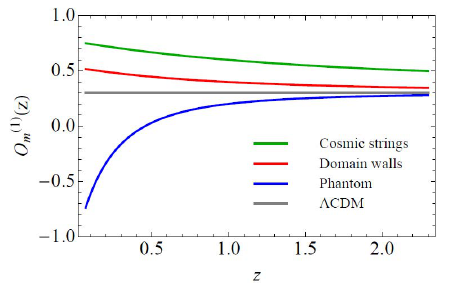
Figure 1. Comparison between dark energy models. The solid grey line represents a Λ CDM model with Ω m = 0.315. Non-interacting cosmic strings with w 0 = − 1/3 are represented by the green line. Static domain walls with w 0 = − 2/3 are represented by the red line, and the phantom model with w 0 < − 1 is represented by the blue